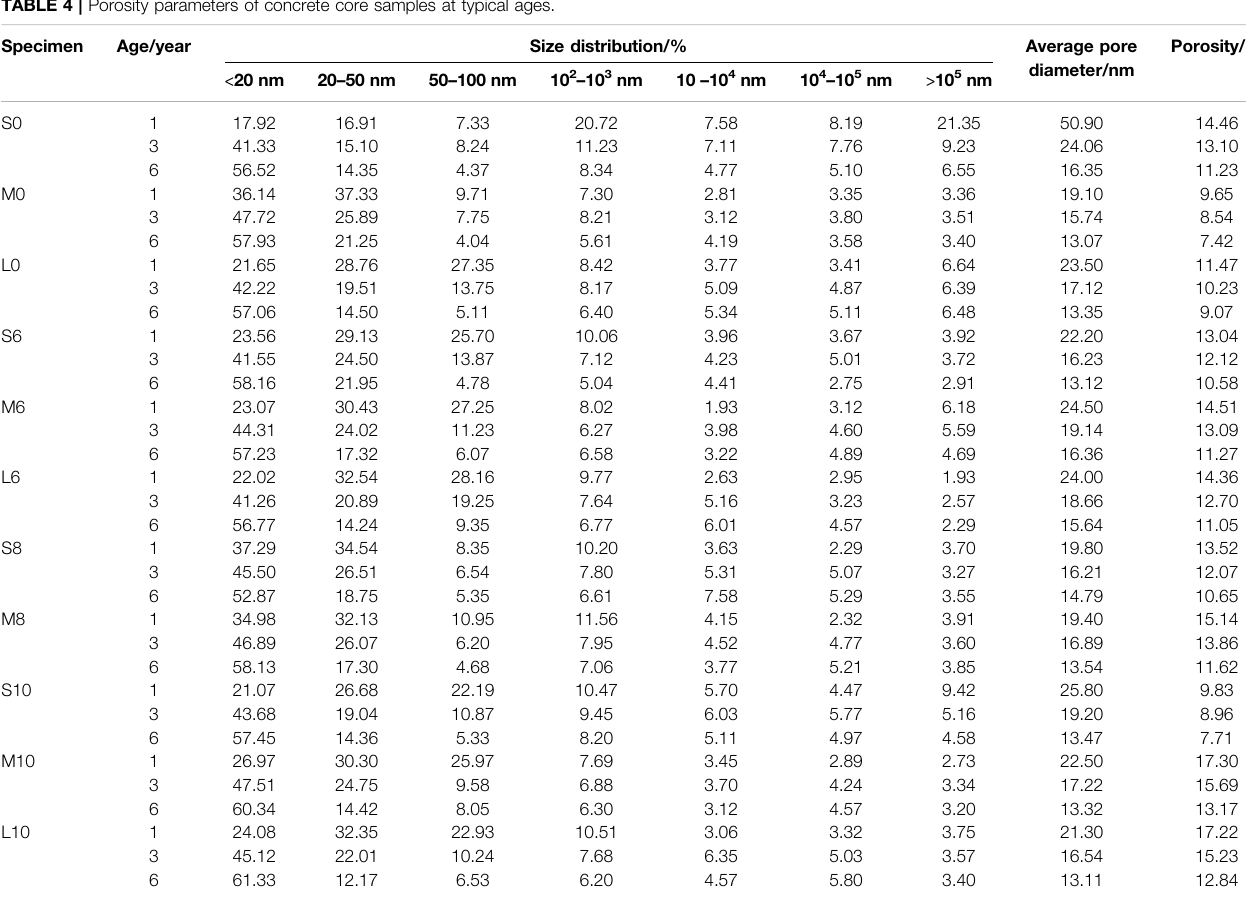
TABLE 4 | Porosity parameters of concrete core samples at typical ages.